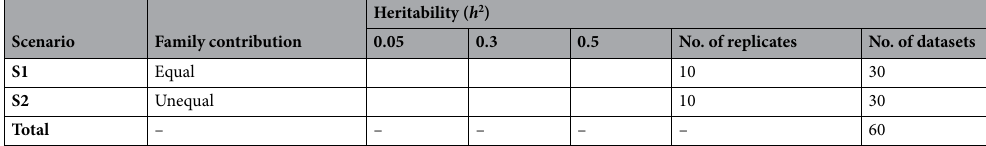
Table 1. The composition of main scenarios and datasets generated for investigating the effect of genotypic error on accuracy of genomic